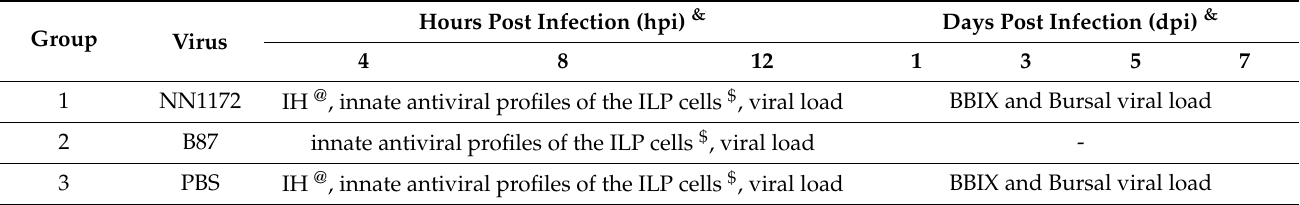
Table 1. The information of the experimental